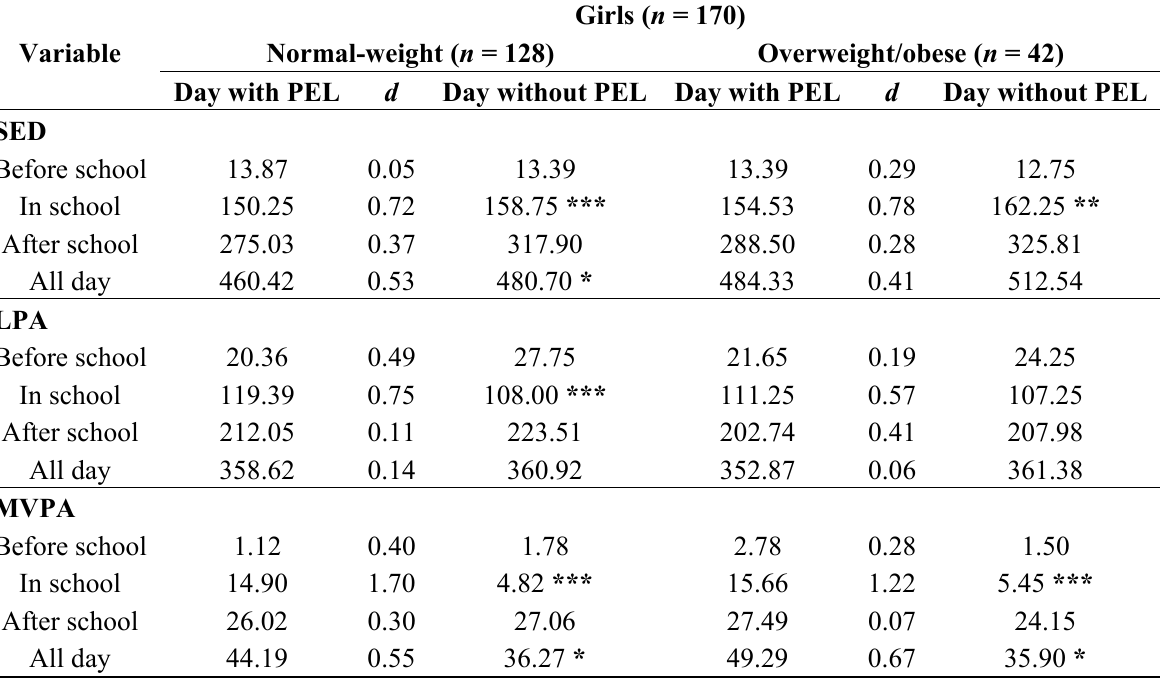
Table 3. Comparison of duration (minutes) of school-day SED, LPA and MVPA (median) in overweight/obese and normal-weight girls between the day with participation in PEL and the day without PEL.